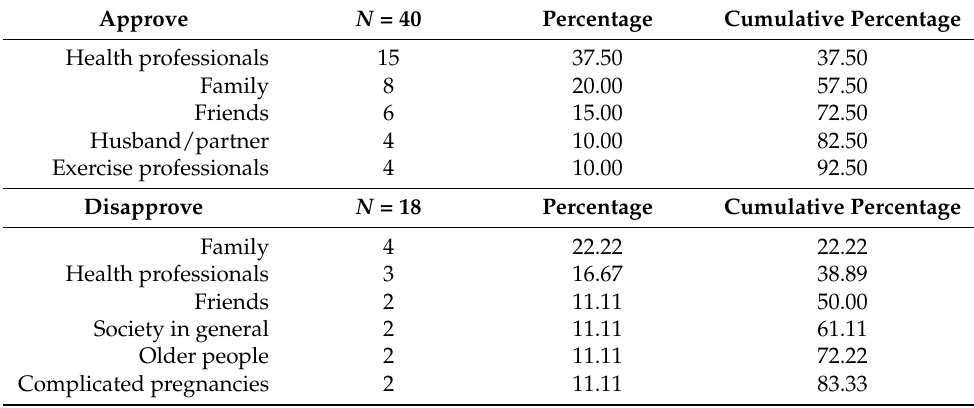
Table 2. Modal salient injunctive normative beliefs of pregnant women in East Kent.